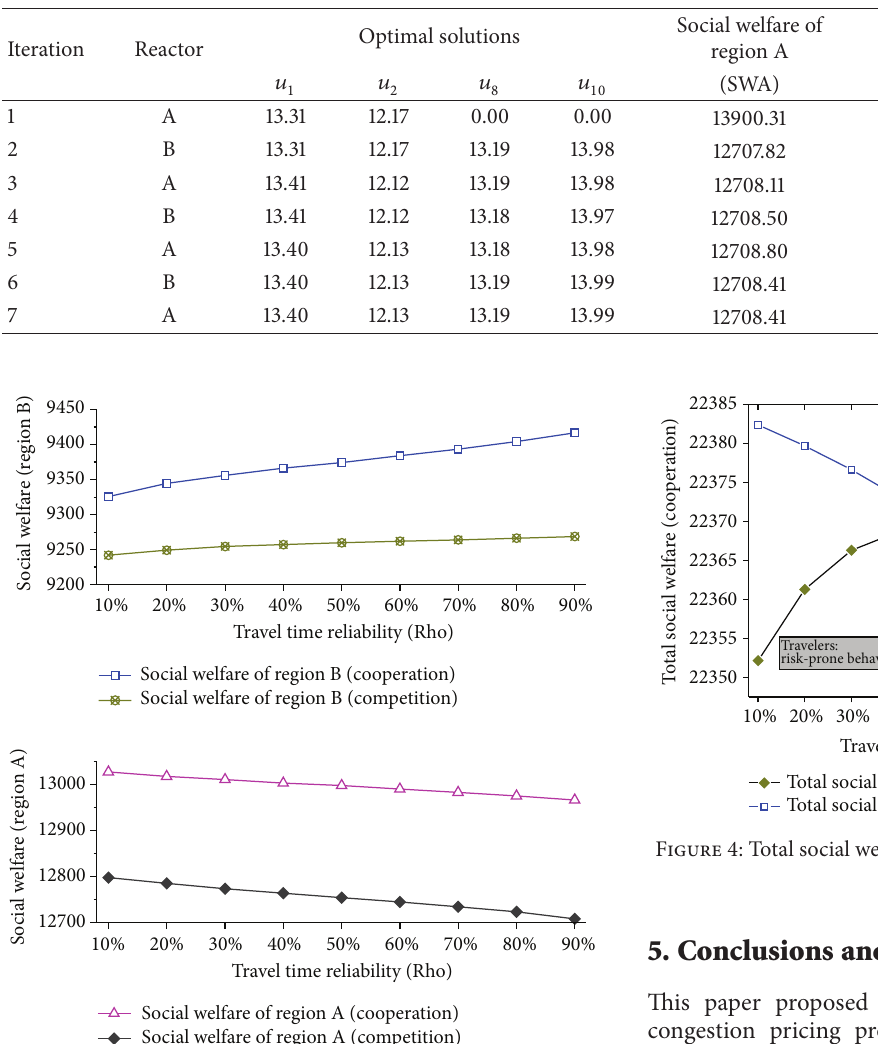
Table 4: The process of the competitive congestion pricing ( 𝜌 = 90 % ).